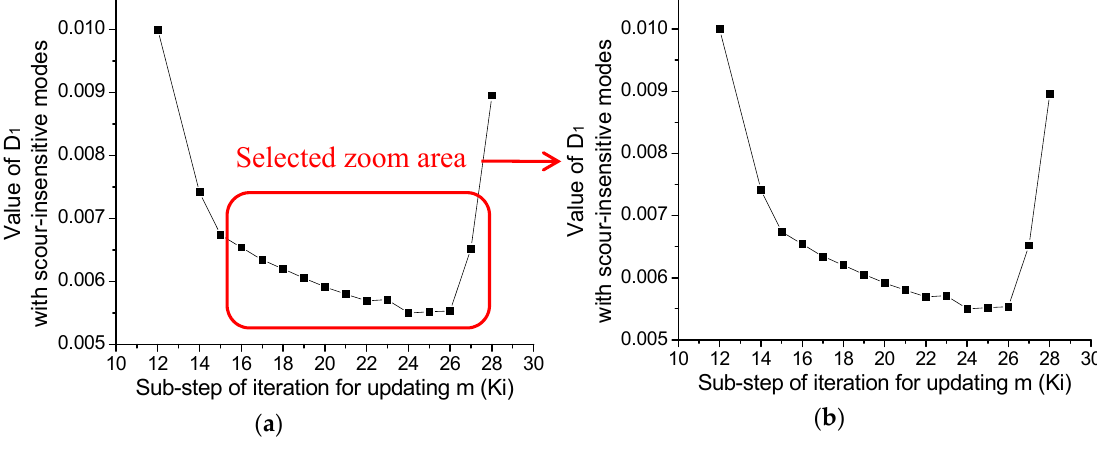
Figure 15. Values of D 1 versus sub-steps of iteration. ( a ) Iteration results at all the 35 sub-step, ( b ) Iteration results in a selected range (10th–30th).